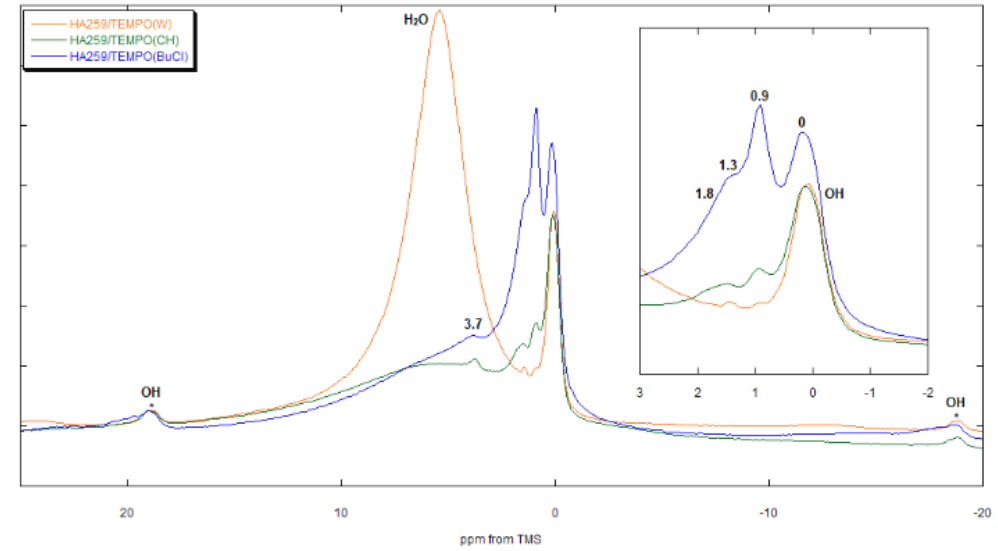
Figure 9. 1 H NMR spectra of the composites obtained via the TEMPO adsorption on HA259 from 0.5 mM solutions in CH, BuCl and W. The spectra were normalized to the same sample mass. Asterisks denote spinning sidebands. The inset shows a zoomed region from − 2 to 3 ppm.